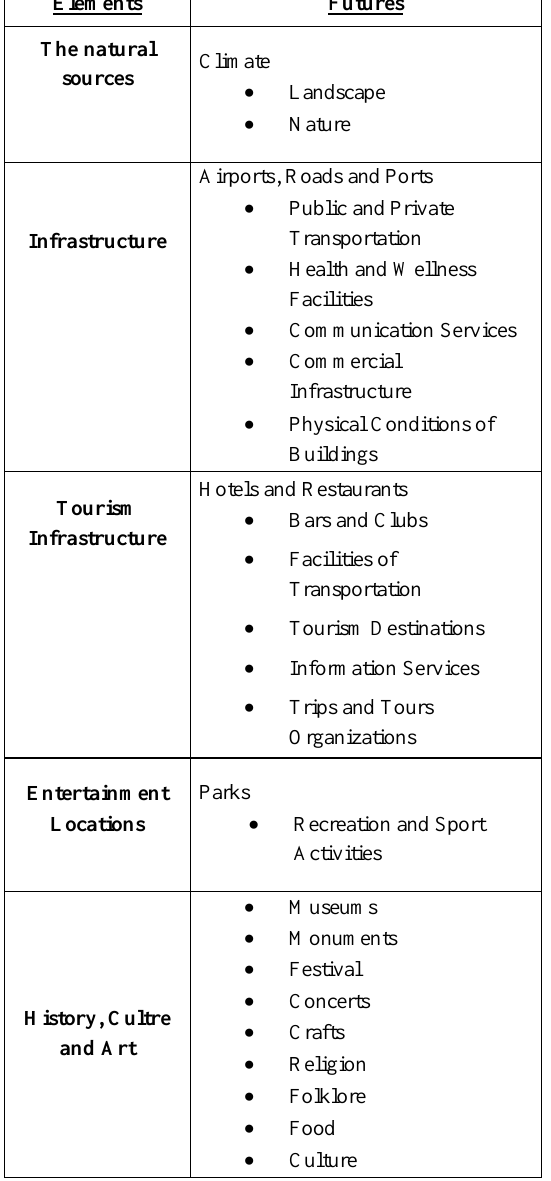
Table 1. Elements Affecting the City Image and Features for Measuring City Image Elements The